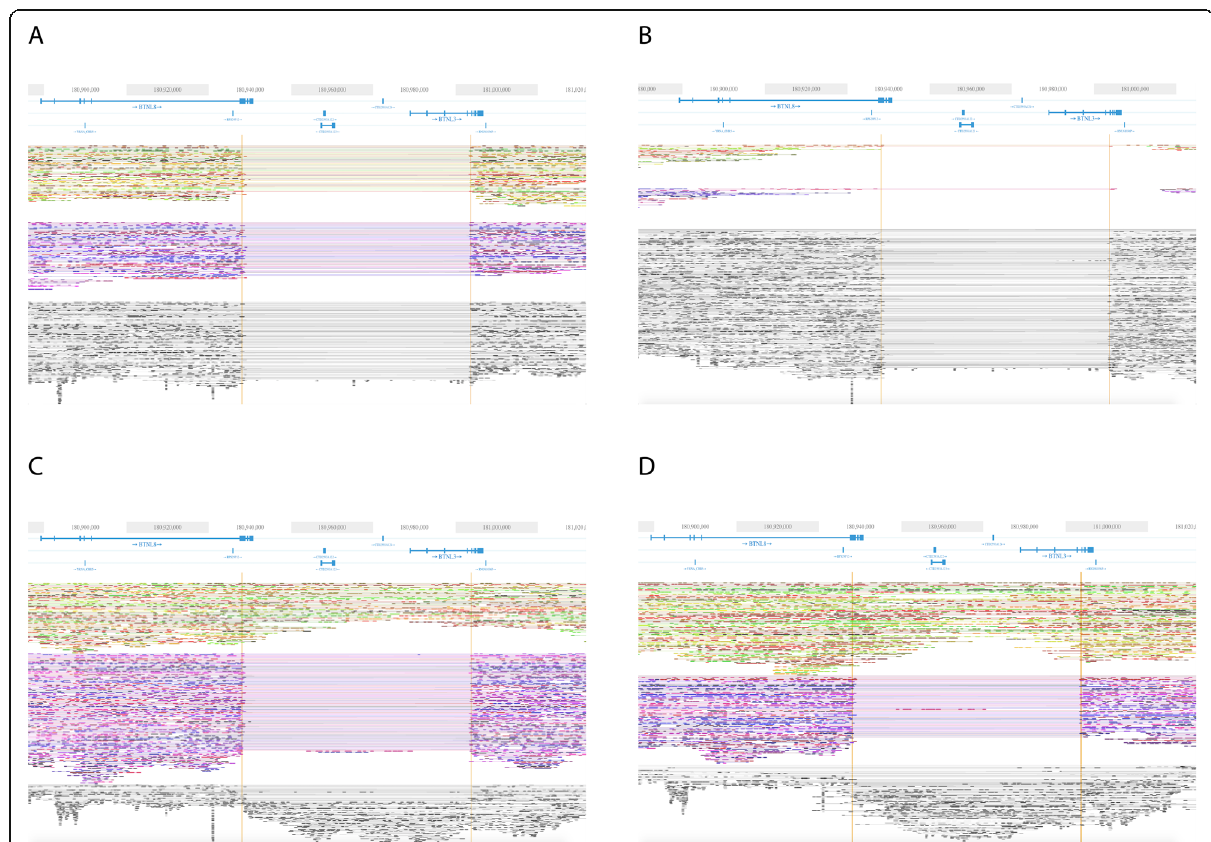
Fig. 3 Linked-read sequencing data for two pHGG patients at the BTNL8-BTNL3 locus. a Homozygous BTNL8-BTNL3 deletion in the tumor profile of patient 6 (G641). b Homozygous deletion in the germline of patient 6 (G641B). c Heterozygous BTNL8-BTNL3 deletion in the tumor profile of patient 1 (SM2932). d Heterozygous deletion in the germline of patient